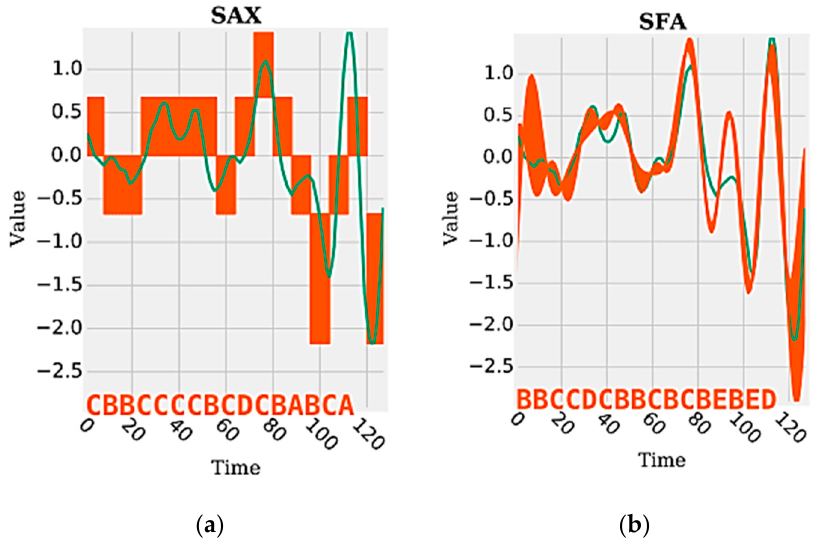
Figure 5. Visual example of the difference between SAX ( a ) and SFA ( b ) [29].